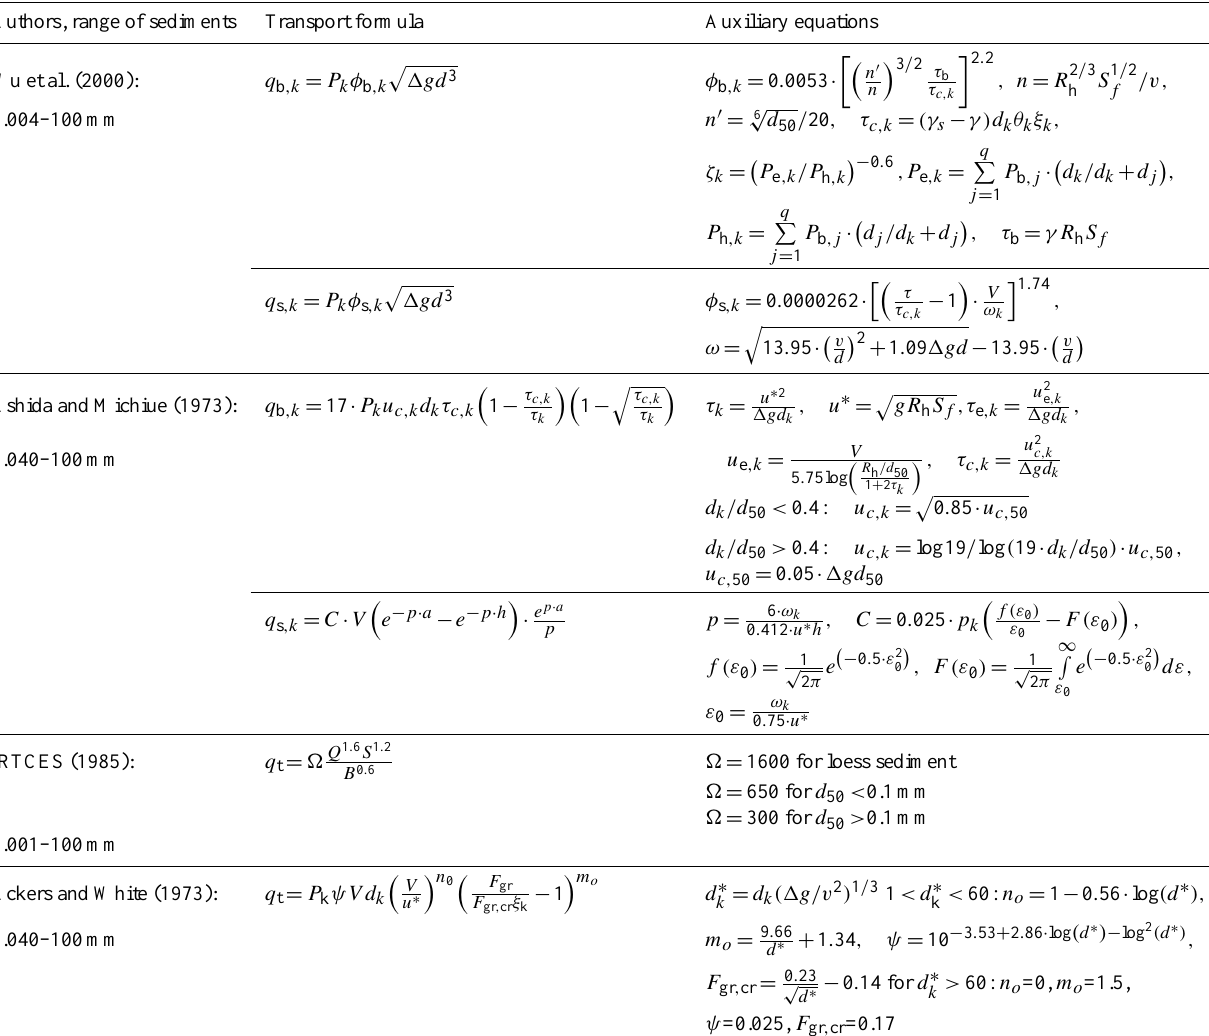
Table 2. Sediment transport formulae in the reservoir module. Authors, range of